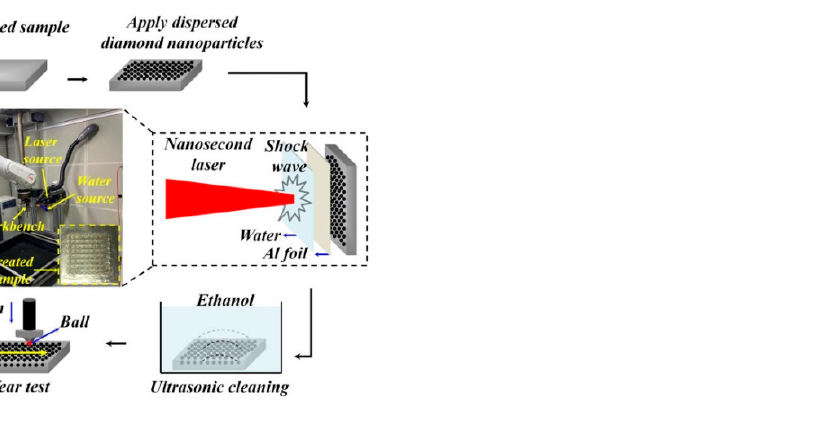
Figure 17. The experimental system of nanoparticle implantation induced by LSP. Reproduced with permission from [123]. Copyright Elsevier, 2021.